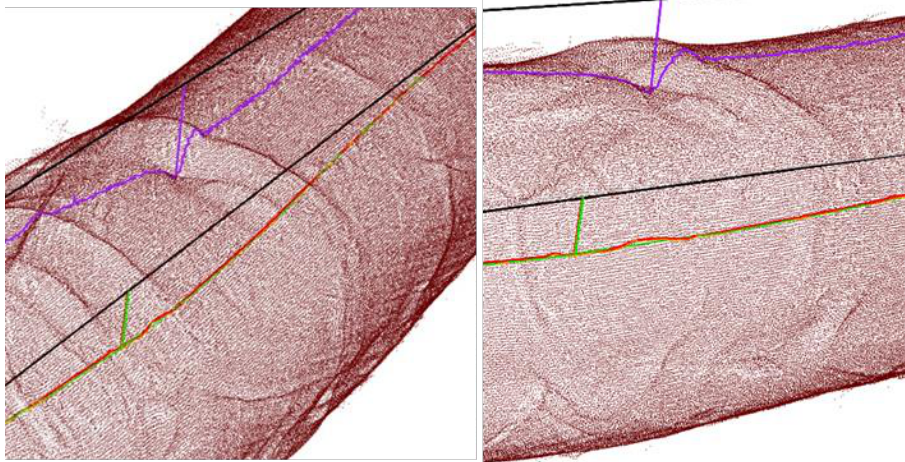
Figure 8. Impact of a hollow in a pine log on the bow height in the contour (purple) and the two centerline approaches (green, red) from two different perspectives.